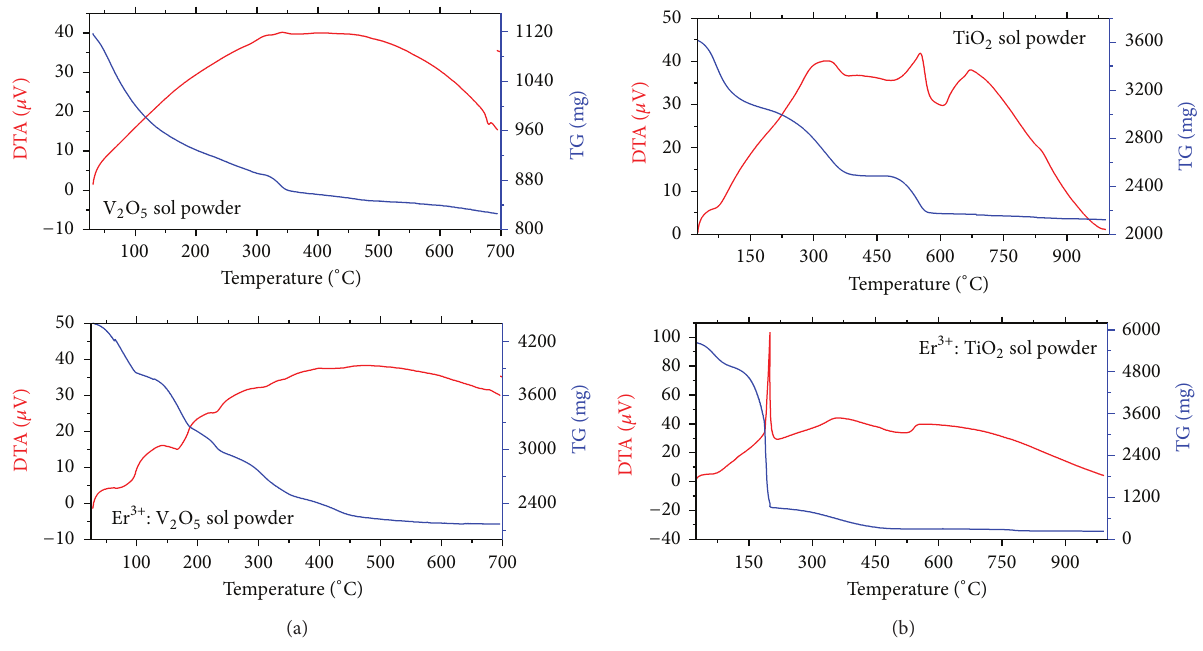
Figure 1: TG/DTA curves of the (a) V 2 O 5 and (b) TiO 2 coating sol